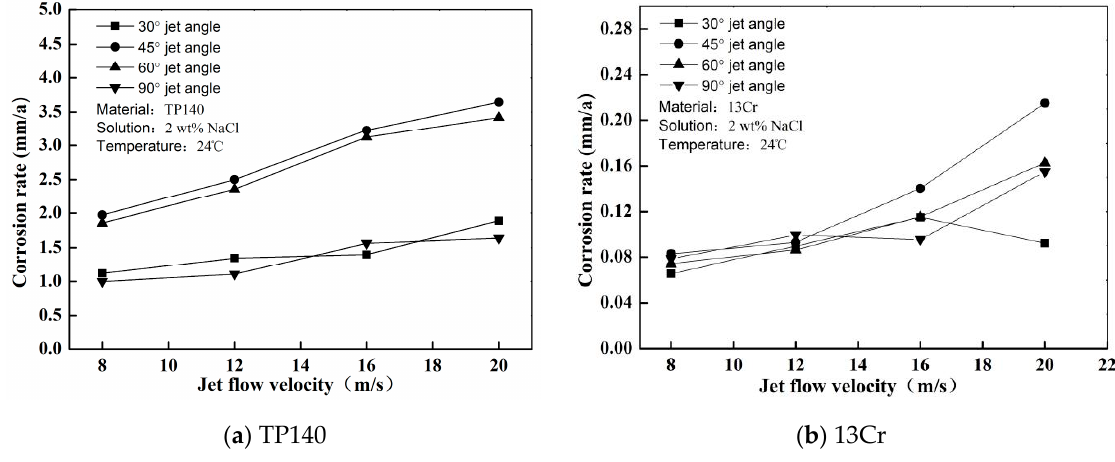
Figure 7. Pure corrosion rate for TP140 and 13Cr steel.